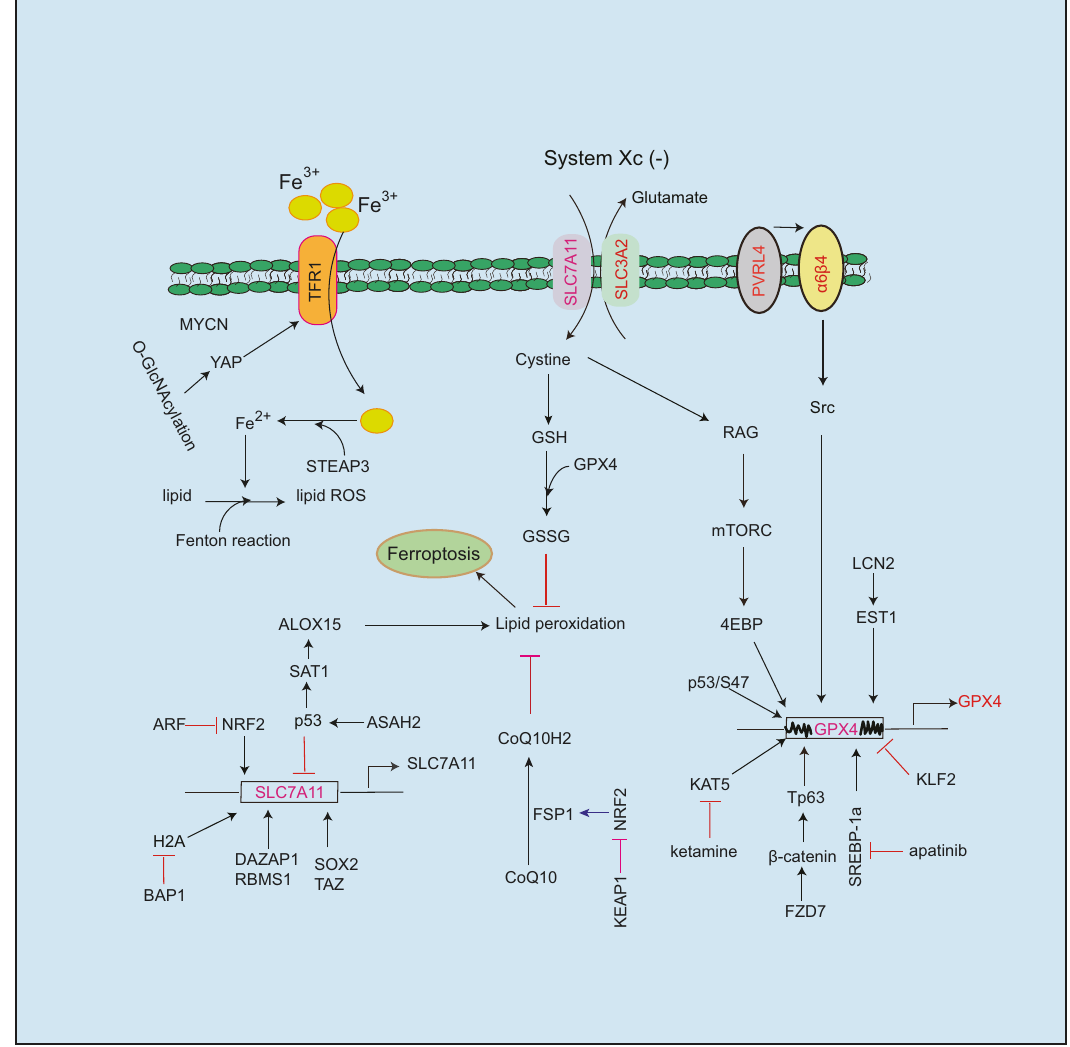
Fig. 1 Regulating pathways of ferroptosis. TFR1 triggers iron uptake, which is regulated by MYCN and YAP pathways. Accumulation of iron facilitates lipid peroxidation and ferroptosis. In contrast, SLC7A11/GPX4 axis prevents ferroptosis by antioxidant role. SLC7A11 or GPX4 expressions are regulated by multiple regulators including NRF2, SOX2, TAZ, EST1, and SREBP-1a etc. Moreover, SLC7A11 mediates cystine uptake, subsequently, activates Rag-mTORC1-4EBP pathway-induced GPX4 protein synthesis. Ferroptosis resistance is blocked by some mediators such as p53, KLF2 etc. In addition to GPX4, FSP1 is a ferroptosis inhibitor by inhibiting lipid ROS accumulation, which is reversed by KEAP1/NRF2 signaling pathway. SLC7A11 facilitates cystine uptake consequent activation of carcinoma (HCC) [8] leading to ferroptosis resistance (Fig. 1). As an downstream GPX4 pathway, subsequently, prevents lipid perox- inhibitor of ferroptosis, DAZ associated protein 1 (DAZAP1) idation accumulation and inhibits ferroptosis [10, 25]. GPX4 is directly binds to SLC7A11 mRNA leading to increased SLC7A11 upregulated by lipocalin-2 in colorectal cancer [26], SREBP-1a in transcription activity, which in turn inhibits ferroptosis in response to sorafenib in HCC [21]. Similarly, RNA binding motif single- stranded interacting protein 1 (RBMS1)/ElF3d (eukaryotic initiation factor 3d) pathway increases SLC7A11 gene transcription [22]. However, BRCA1-associated protein 1 (BAP1) blocks ubiquitination of histone 2A leading to inhibition of SLC7A11 gene transcription, subsequently, increases lipid peroxidation and promotes cancer cell ferroptosis [23]. In recurrent breast tumors, epithelial- mesenchymal transition-induced discoidin domain receptor 2 expression facilitates breast cancer cell growth, while it increases 1080 cells [32]. In addition to regulation of GPX4 gene expression, the sensitivity of ferroptosis by activation of YAP/TAZ pathway in GPX4 protein undergoes degradation [33]. Activating transcription response to erastin [24]. However, YAP/TAZ pathway-mediated factor 4 mediates heat shock protein family A (Hsp70) member 5 SLC7A11 expression inhibits ferroptosis in HCC [8]. This contra- expression, which in turn binds to GPX4 resulting in increased dictory observation may be derived from different experimental GPX4 protein stability with unclear mechanism in pancreatic contexts.